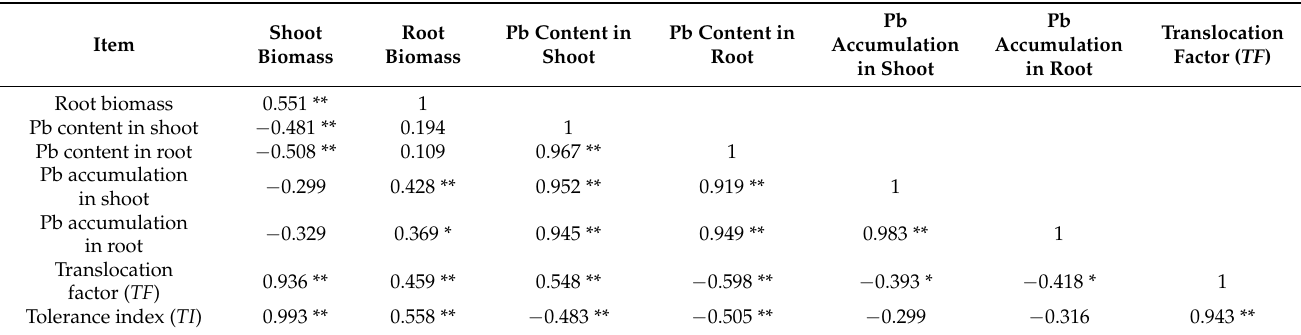
Table 3. Pearson correlation coefficients of biomass, Pb content in root and shoot, TF and TI of the tested M. floridulus